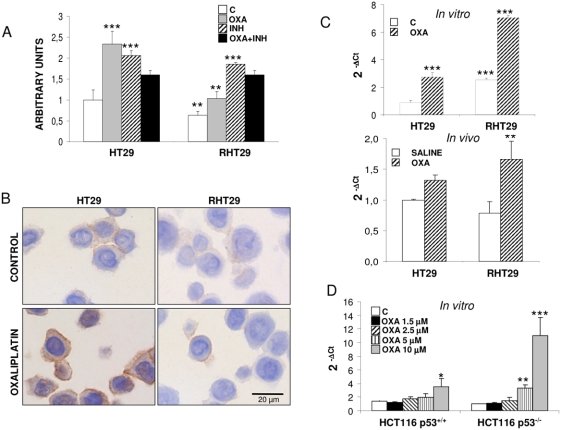
Modulation of cell surface Fas expression in HT29 and RHT29 cell lines.To analyze the expression specifically in the plasma membrane, Fas receptor was determined by A) FACS analysis or B) by immunohistochemistry in a cell line microarray, as described in Materials and Methods. Fas mRNA expression under oxaliplatin treatment was also determined C) in vitro and in vivo for the HT29 and RHT29 cell lines, D) and also in vitro for the HCT116 p53+/+ and HCT116p53−/− cell lines. Results are represented as mean±SEM for 5 samples per group in the in vitro experiments (C and D) and for 10 animals per group in the in vivo determinations (C). Values that are significantly different between control and treated group by ANOVA analysis are indicated by *p<0.05,**p<0.001,***p<0.0001. INH: inhibitor (1,10-phenantroline monohydrate), OXA: oxaliplatin.